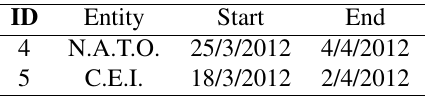
Table 5. Sample historical database